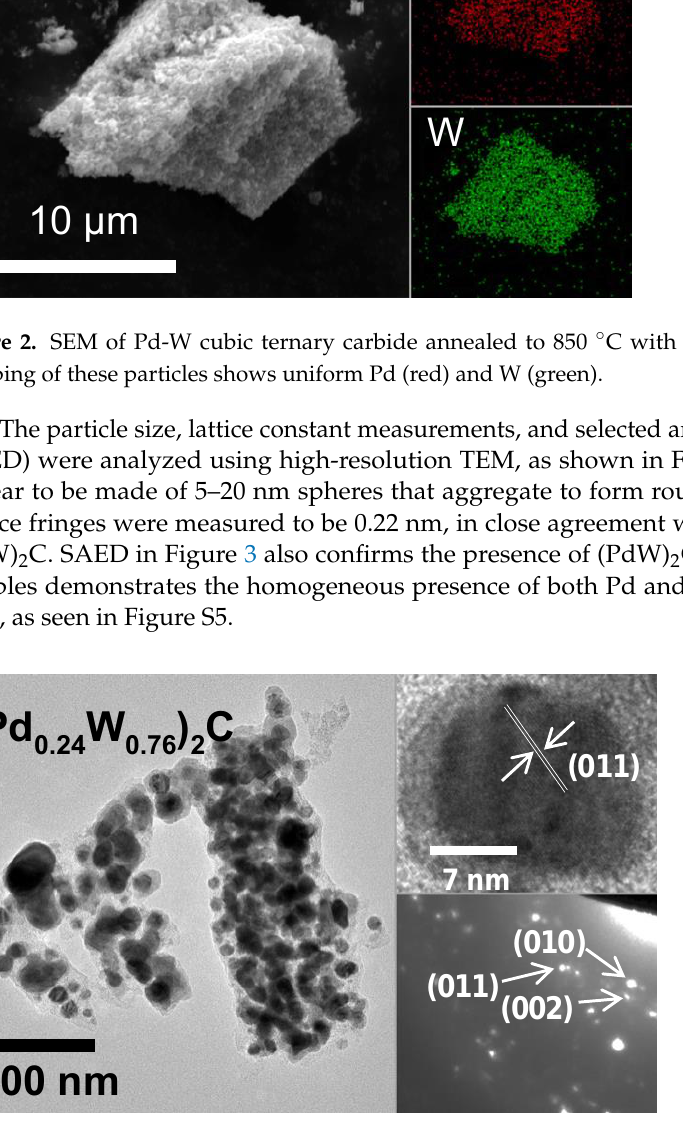
Figure 3. Bright-field TEM image of Pd-W hexagonal ternary carbide annealed to 975 °C with 24% Pd. The lattice fringe analysis and SAED further confirm the hexagonal structure.